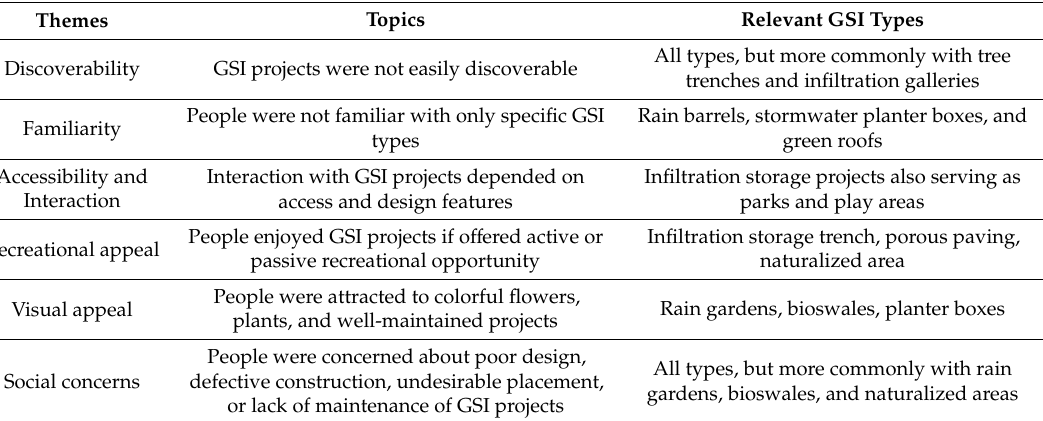
Table 6. Social Perception of GSI Based on Intercept